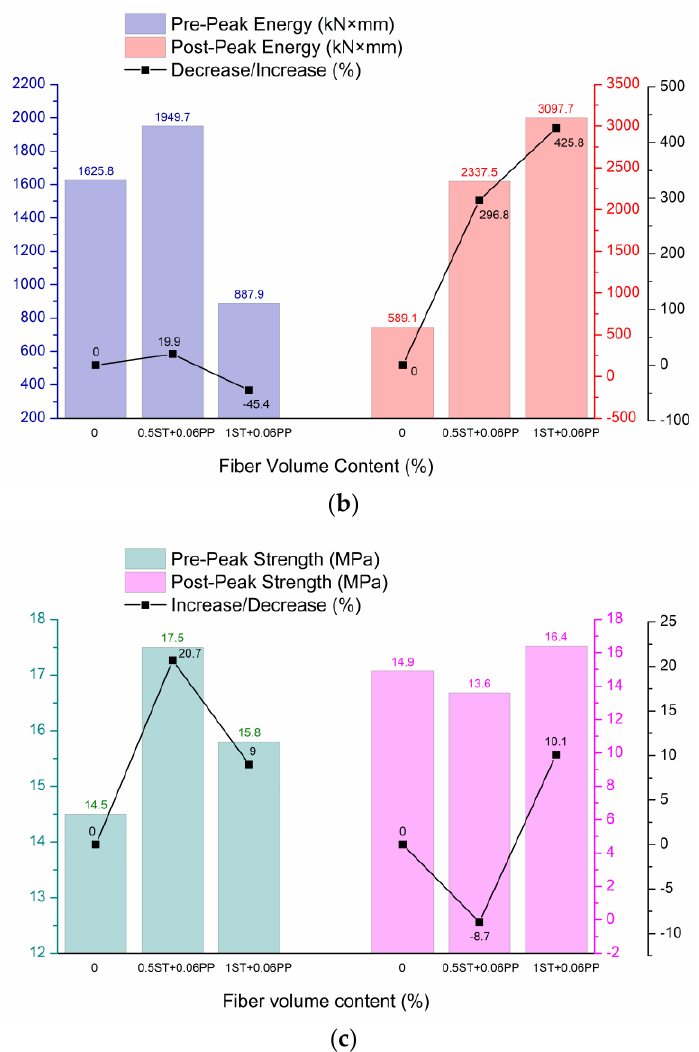
Figure 14. Comparison of slab ( a ) Over-strength and ductility factor ( b ) Pre- and post-peak energy ( c ) Pre- and post-peak strength.